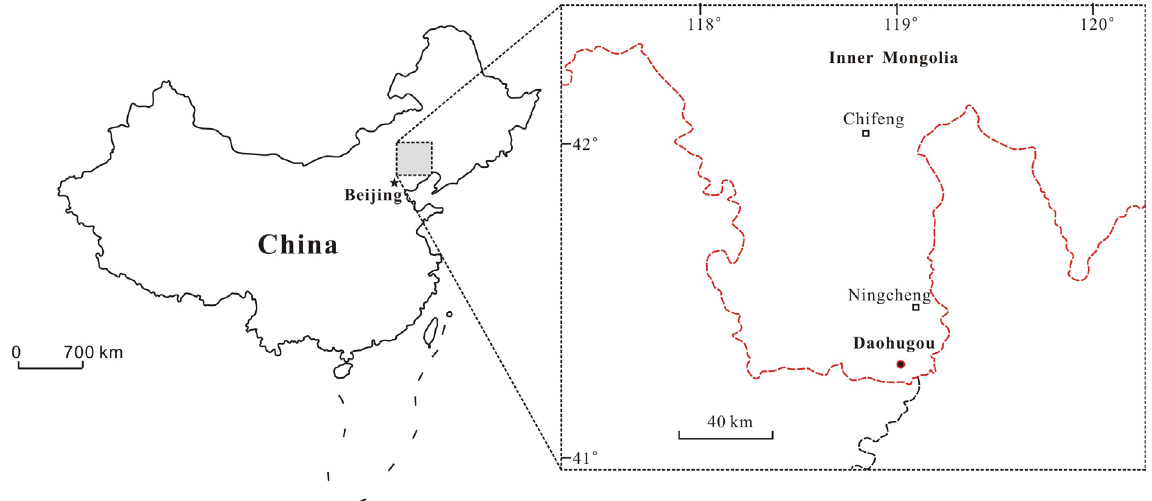
Fig. 1. Geographical sketch map showing the insect fossil locality in Daohugou area, Ningcheng City, Inner Mongolia,